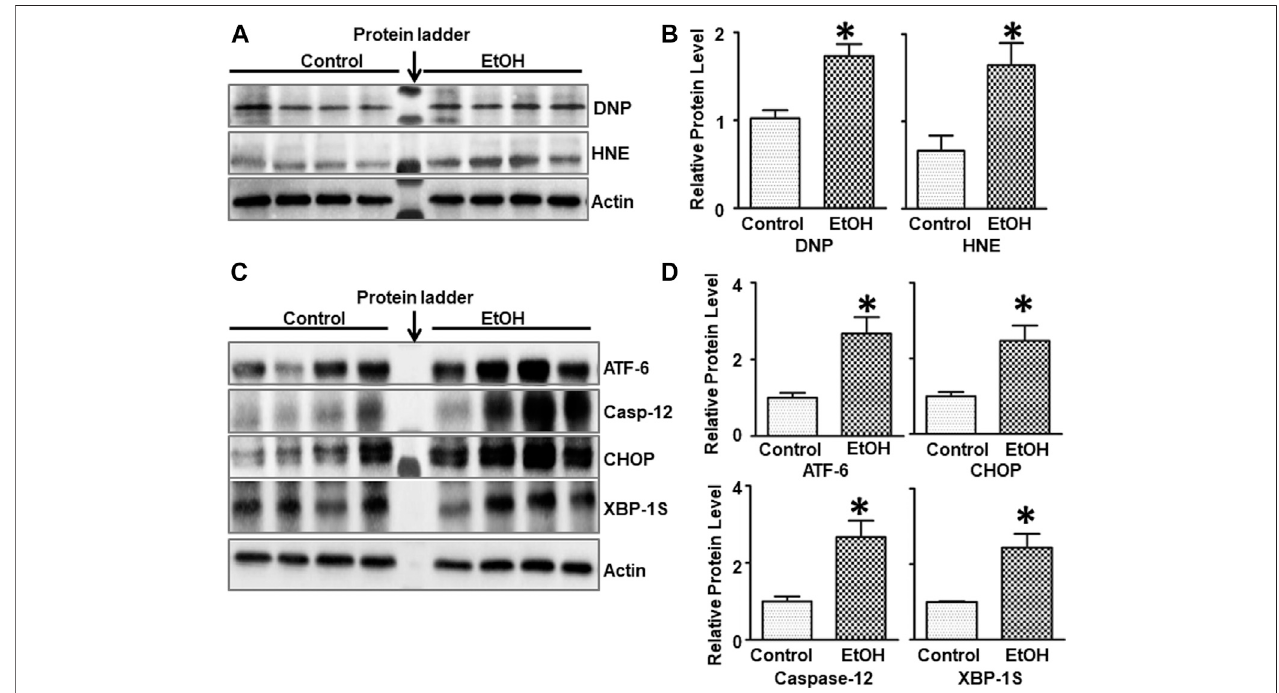
FIGURE 3 | Effects of chronic alcohol exposure on oxidative stress and ER stress in the brain. (A) The expression of 4-HNE and DNP in the cerebrum was determinedbyIB. (B) Therelativeamounts of4-HNEandDNPwerequanti fi edandnormalizedtotheexpression ofactin. (C) Theexpression ofERstressmarkers,ATF- 6,CHOP,Caspase-12,andXBP-1sinthecerebrumwasdeterminedbyIB.Therelativeamountsofexpressionwerequanti fi edandnormalizedtotheexpressionofactin. (D) Therelativeamounts ofER stress markers werequanti fi ed and normalizedto theexpression ofactin. Theresults were expressed asthemean ± SEM; n (cid:2) 4 for each group. * p < 0.05 denotes a statistically signi fi cant difference from the control group.